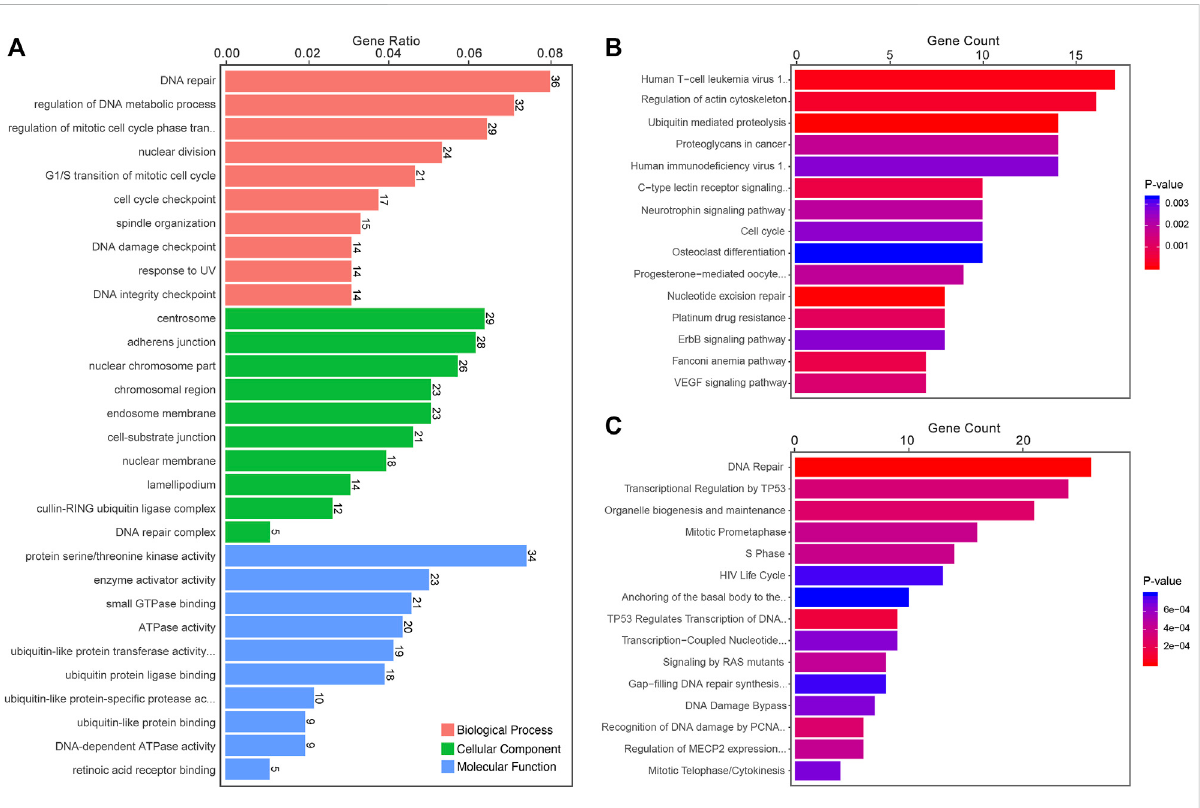
FIGURE 3 FunctionalpredictionsofdifferentiallyexpressedcircRNAsbetweenLUAD-BMandLUAD. (A) Top10GOanalysistodemonstratethemolecular functions of dysregulated circRNAs. (B) Top 15 signi fi cant enrichment KEGG pathways of dysregulated circRNAs. (C) Top 15 signi fi cant enrichment Reactome pathways of dysregulated circRNAs. LUAD-BM, lung adenocarcinoma with bone metastasis; LUAD, lung adenocarcinoma; circRNAs, circular